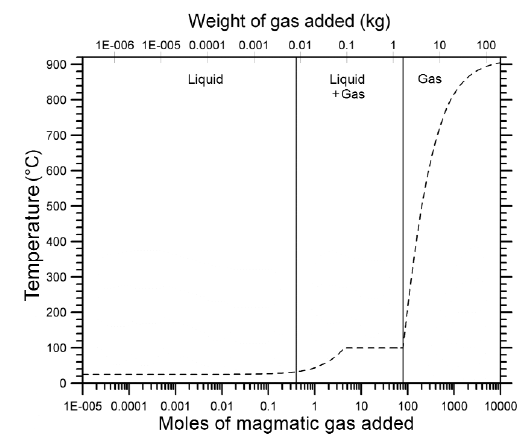
Fig. 2. Changes in temperature during the progres- sive addition of hot (915°C) magmatic gas into 1000 g of pure water initially at 25°C. Pressure was kept at 0.1 MPa throughout the